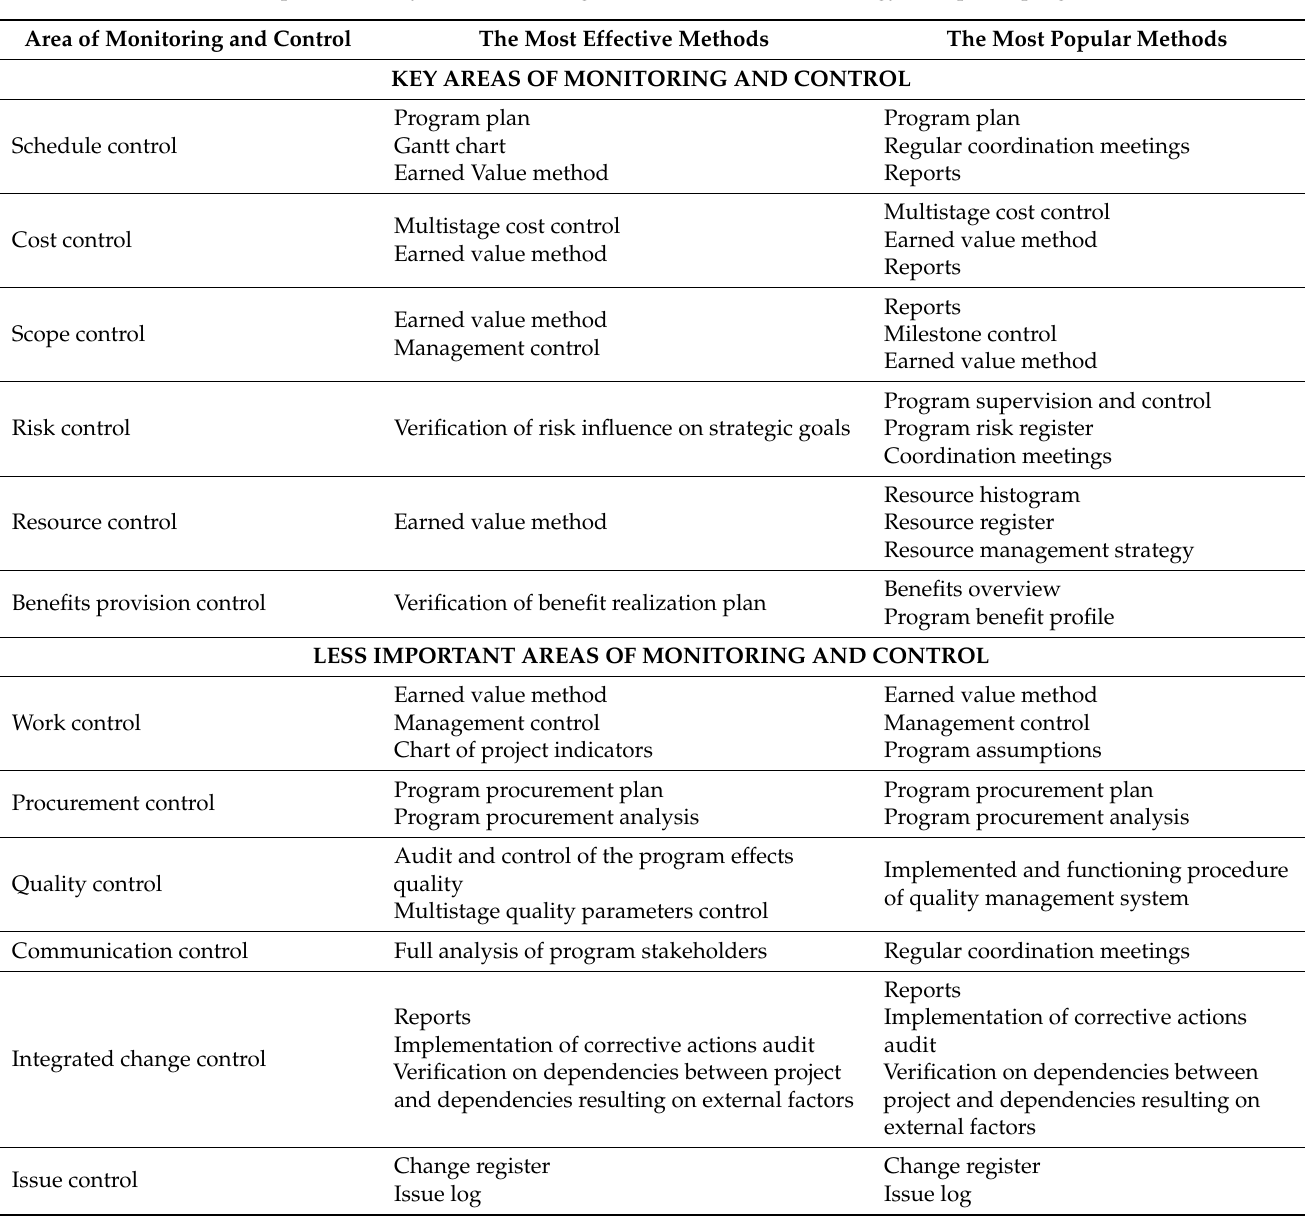
Table 3. Comparative analysis of monitoring and control methods in energy enterprises programmes. Area of Monitoring and